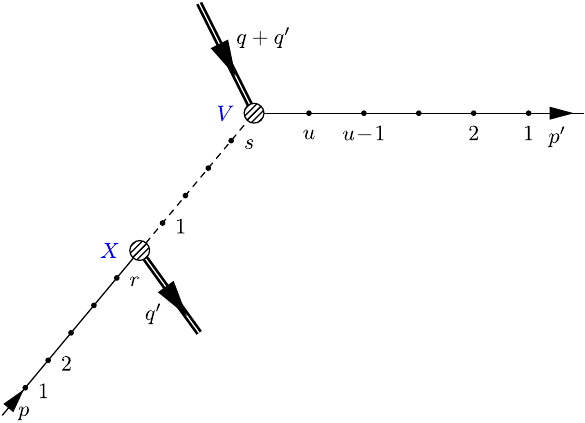
Fig. 7 Defining the p (cid:6) and p legs for the process, χ f → χ f at the n th order. There are w vertices on the p leg, of which r are on the initial fermion (solid) line and s on the intermediate scalar (dashed) line; and u vertices on the final p (cid:6) fermion (solid) line so that n ≤ u + s + r = m ≤ 2 n